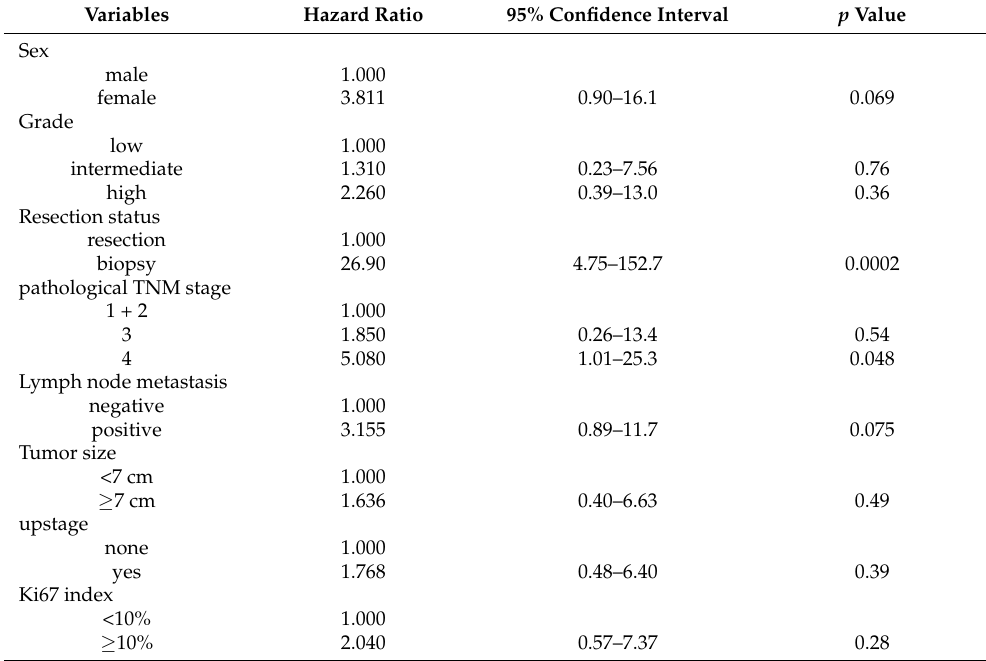
Table 3. Univariate analysis of overall survival.